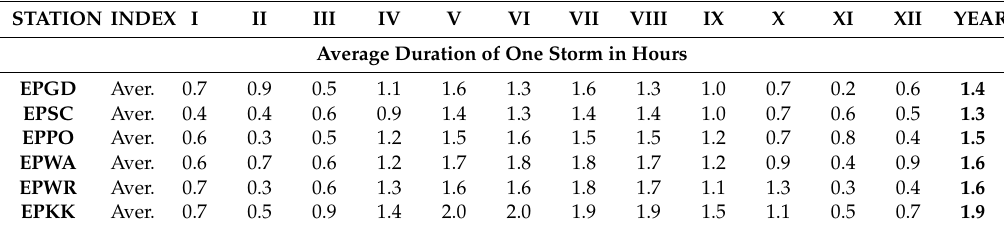
Table 3. Average (Aver.) duration of one storm in hours